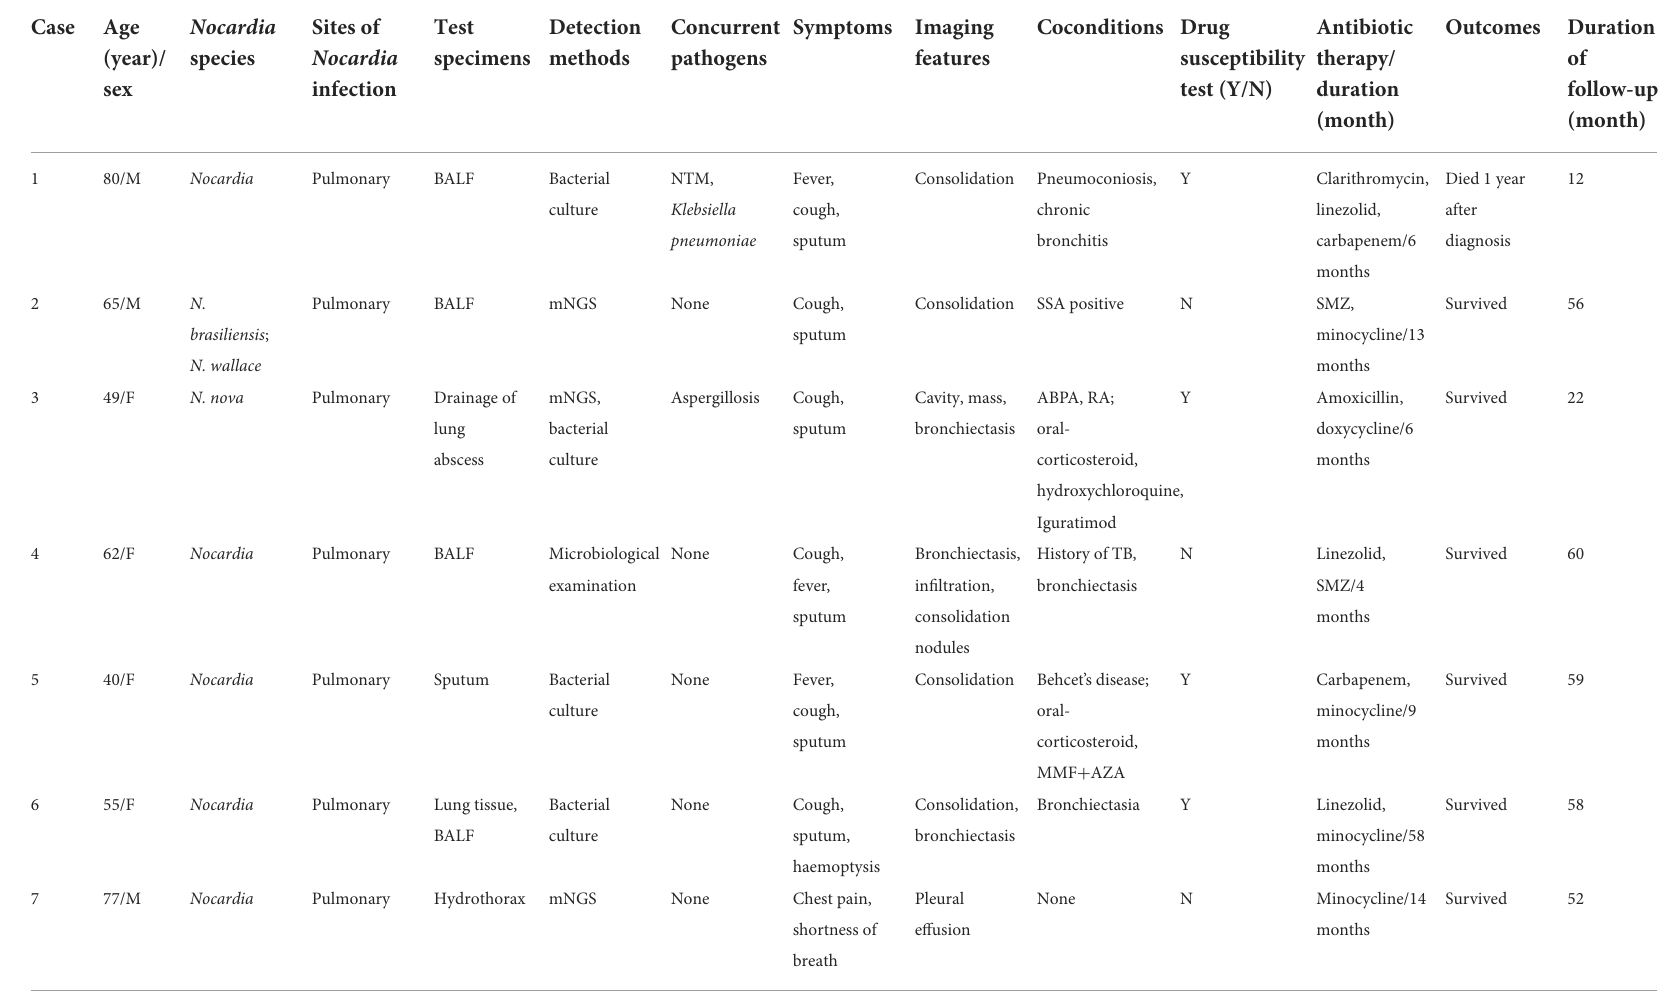
TABLE 1 Summary description of 19 cases from two